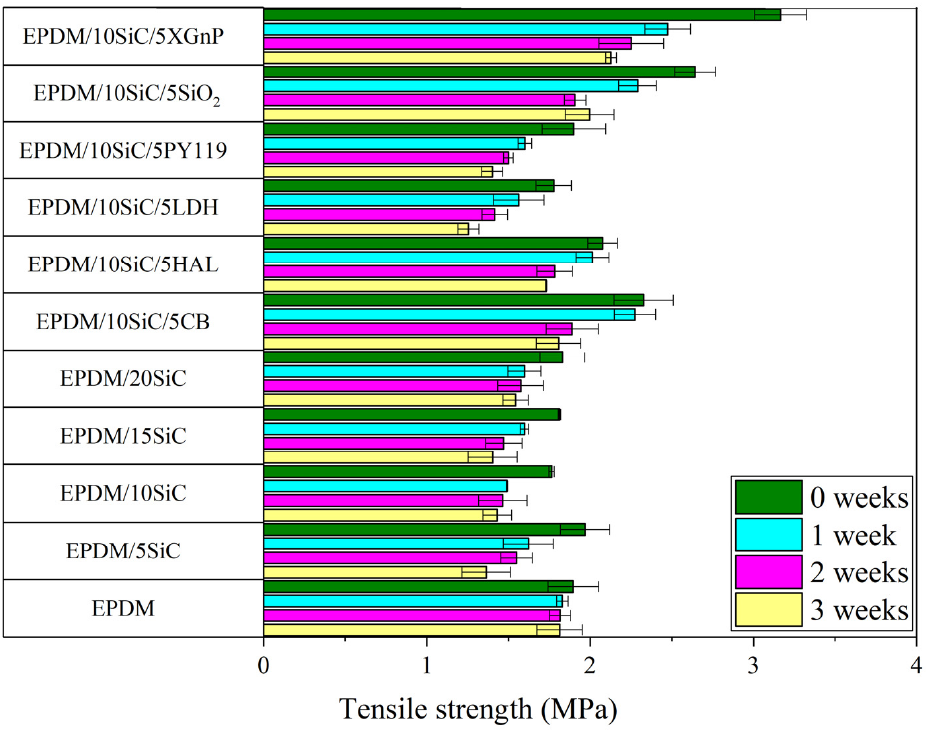
Figure 3. Tensile strength of composites before and after thermo-oxidative ageing.